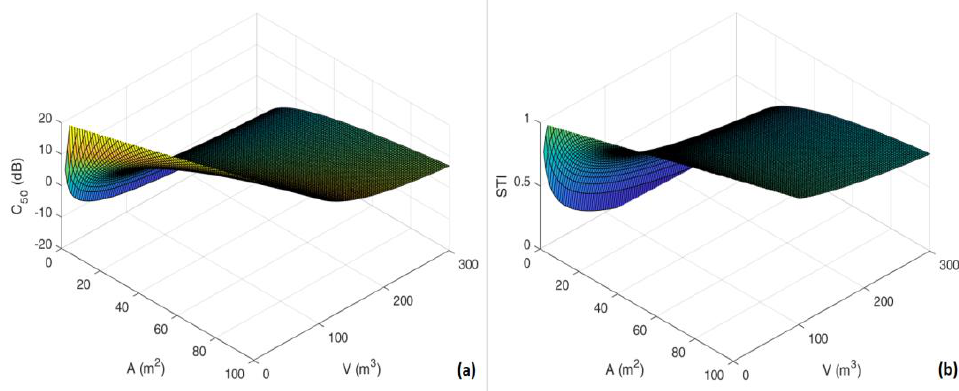
Figure 3. Graphs of two-variable functions of ( a ) Clarity index C 50 (dB) for a fixed r = 2 m value; ( b ) Speech Transmission Index STI . ( b ) Speech Transmission Index STI